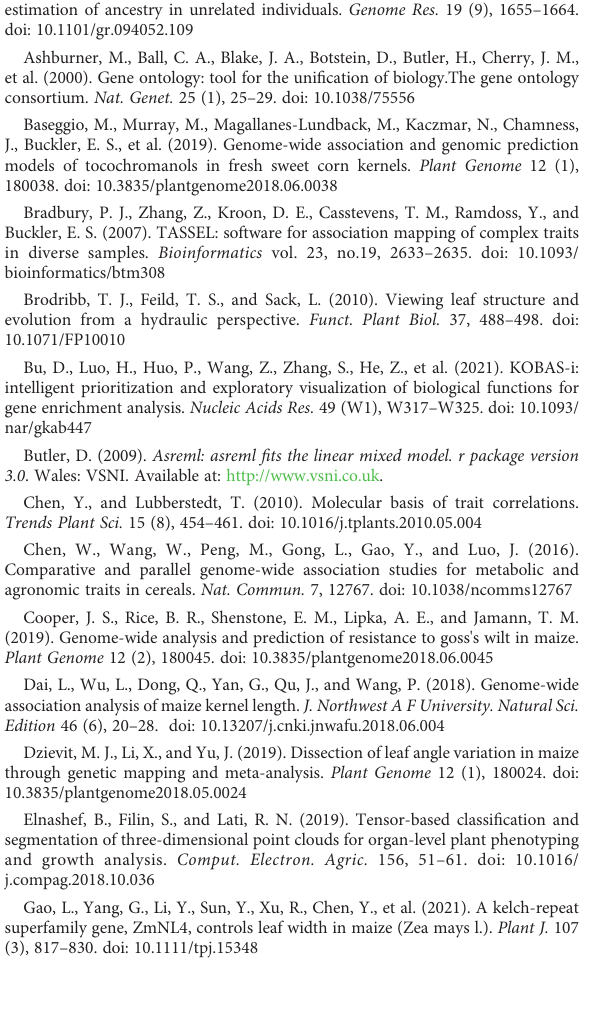
ALGORITHM FILE S3 The leaf midrib classi fi cation